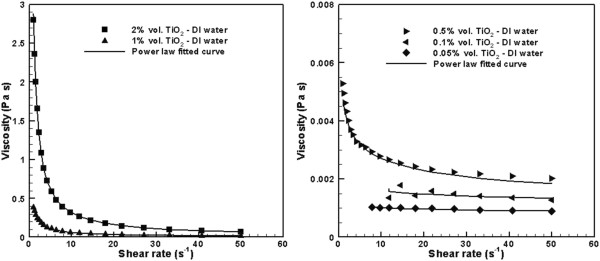
Viscosity of TiO2-DI water solutions.